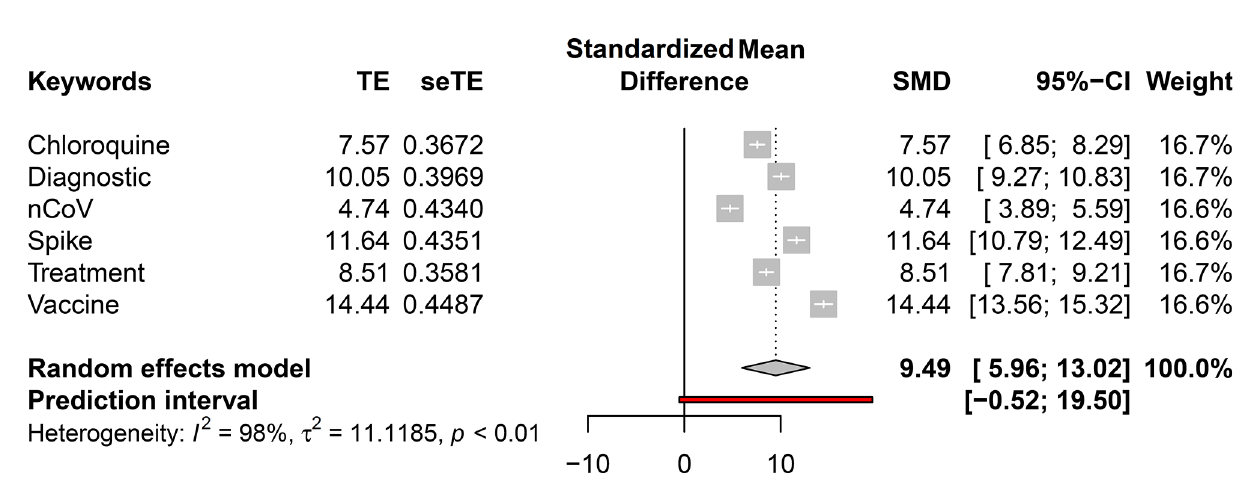
FIGURE 2 | Introductory meta-analysis based on the average number of publications before and during the pandemic